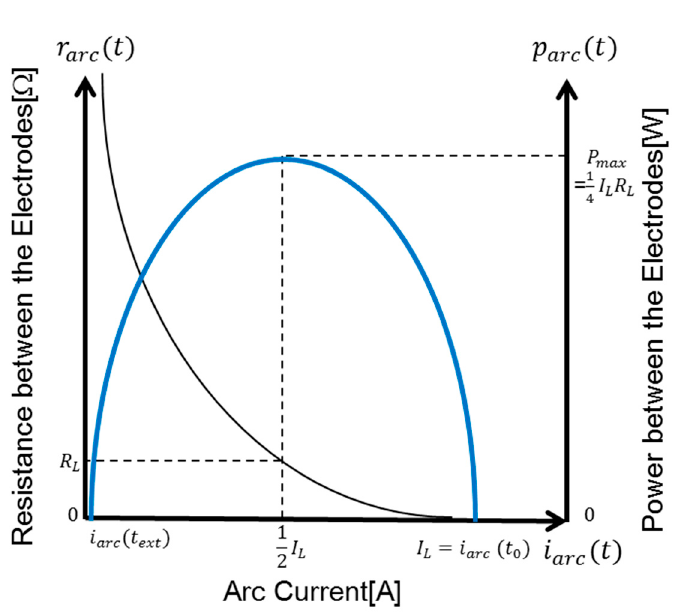
Figure 16. p arc , r arc , i arc relation Figure16. (cid:1868) (cid:3028)(cid:3045)(cid:3030) , (cid:1870) (cid:3028)(cid:3045)(cid:3030) , (cid:1861) (cid:3028)(cid:3045)(cid:3030) relation graph.